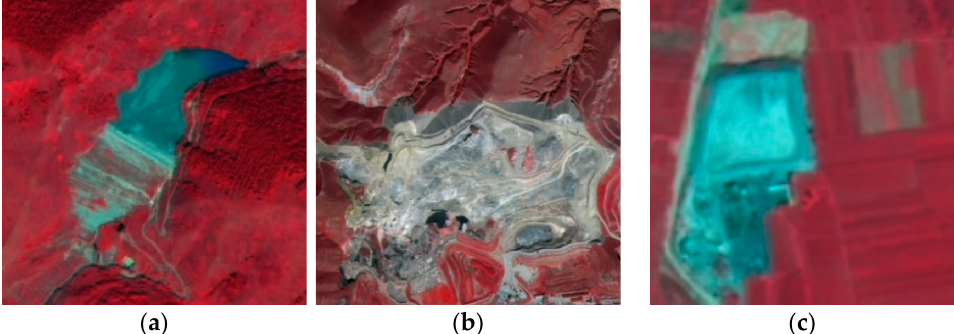
Figure 2. Examples of different types of tailings ponds as they appear in GF-6 images. ( a ) Cross-valley type, ( b ) hillside type, and ( c ) stockpile type.